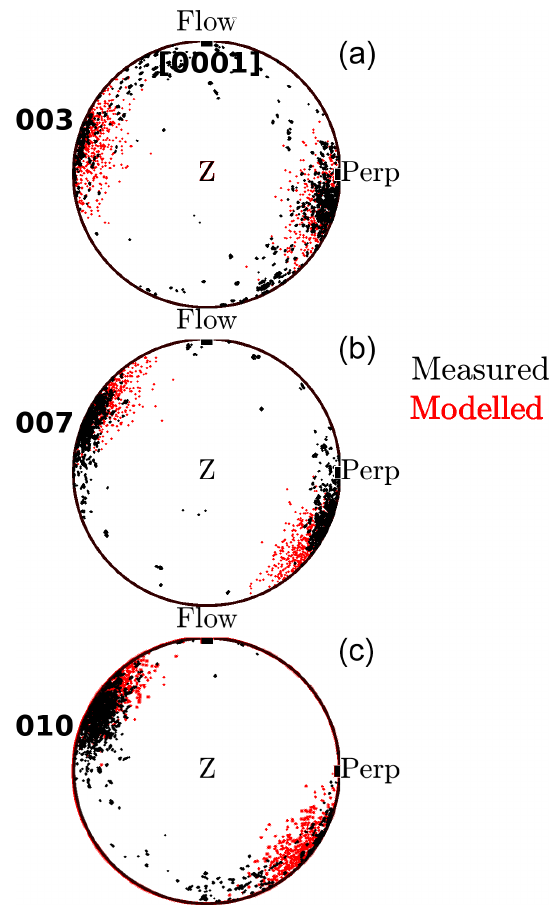
Figure 11. Measured (black) and modelled (red) CPO geometries. c -axis orientations in an upper-hemisphere stereographic projection are shown. The VSP orientations of the Flow and Perp profiles are labelled. (a) Sample 003; (b) sample 007; (c) sample